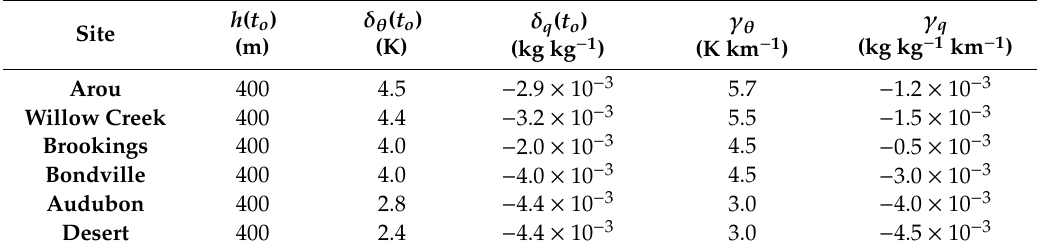
Table 2. The magnitudes of the initial conditions for h , δ θ , and δ q , as well as γ θ and γ q for the study